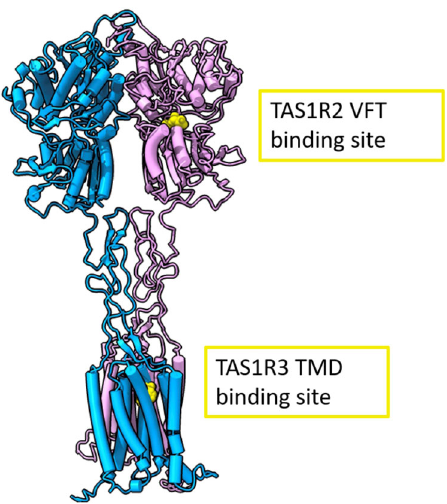
Fig. 1 Full human sweet taste TAS1R2/TAS1R3 receptor model with the TAS1R2 monomer colored in pink and the TAS1R3 monomer in